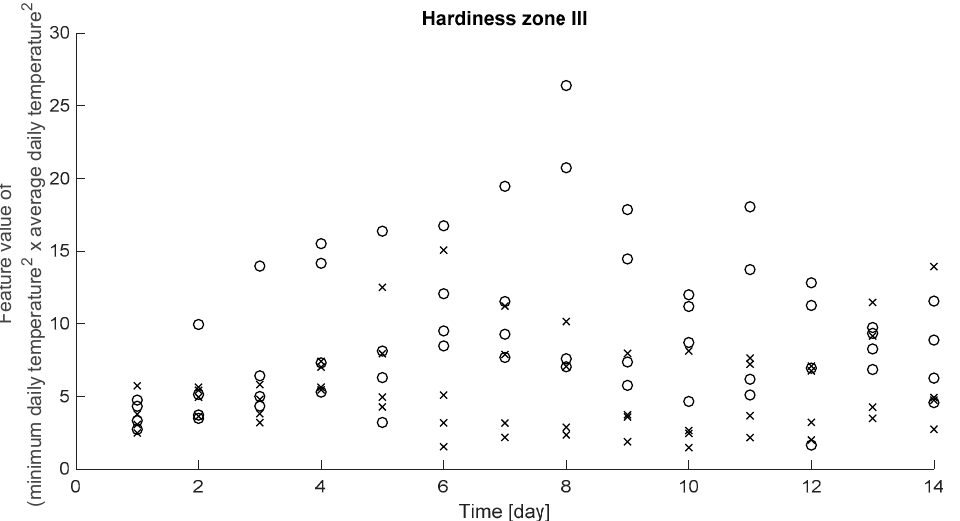
Table 3. Results of the statistical feature evaluation.